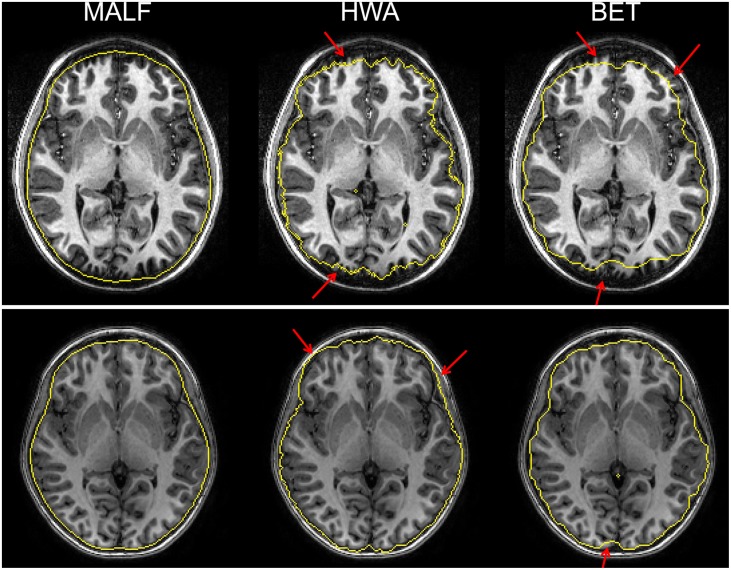
The top and bottom panels show automated skull-stripping results of individual subjects of the pediatric dataset, different for each panel, superimposed on their corresponding T1-weighted image. From left to right: results obtained from MALF, HWA, and BET. Regions pointed to with a red arrow indicate regions where inaccurate skull-stripping has occurred.